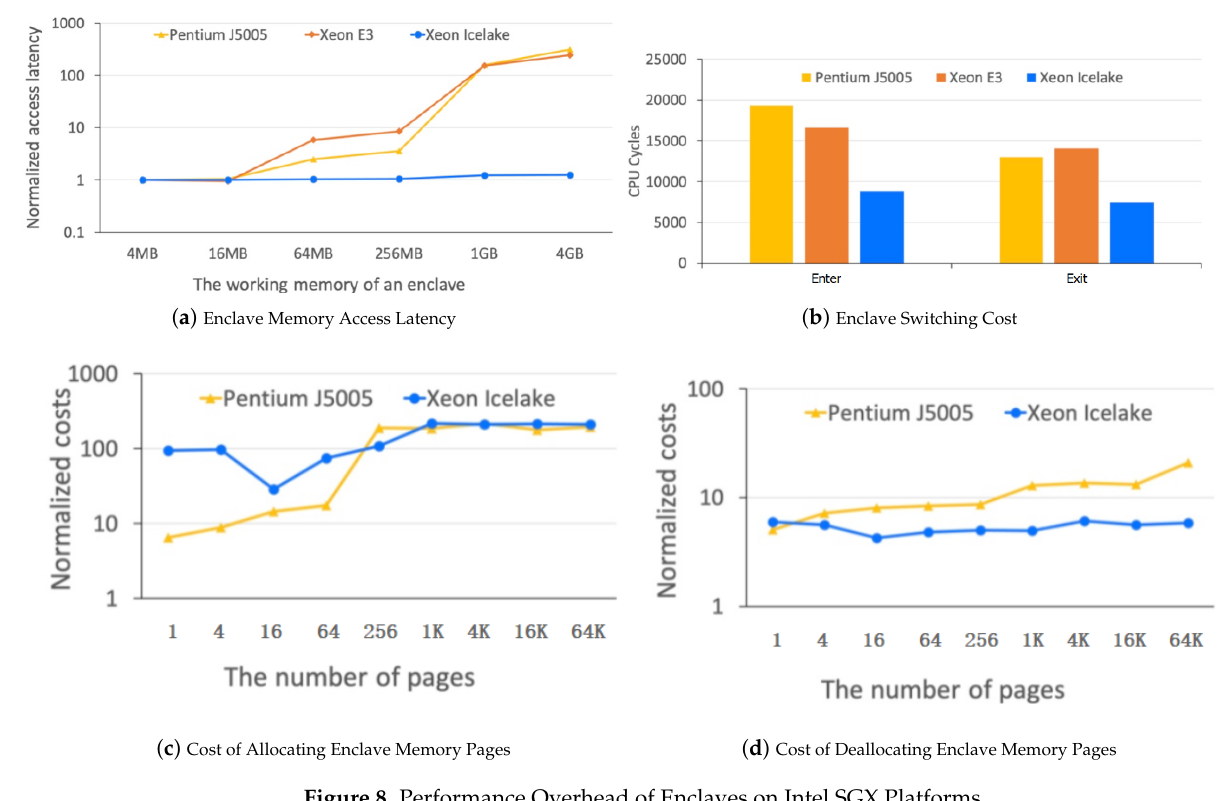
Figure 8. Performance Overhead of Enclaves on Intel SGX